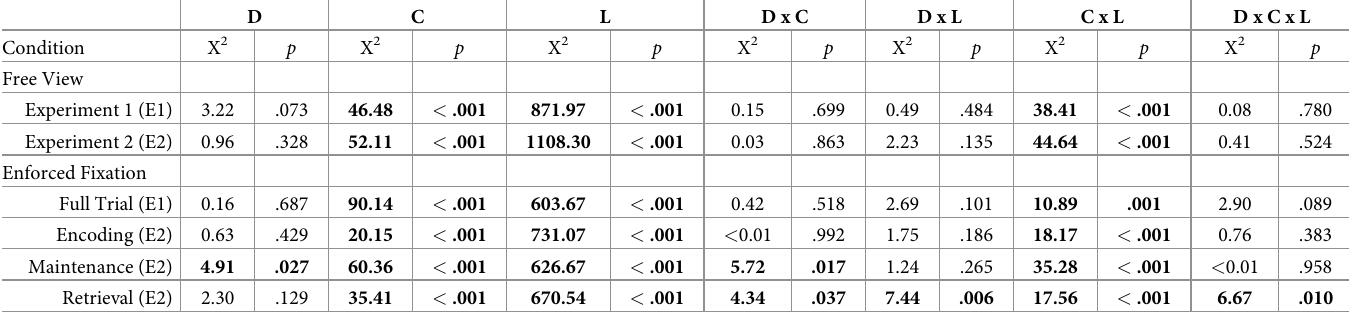
Table 2. Type II Wald chi-square tests used to evaluate the significance of the main effects and interactions of distance (D), configuration (C), and location change (L) in the generalized linear mixed effect models fitted to the experimental conditions of Experiments 1 and